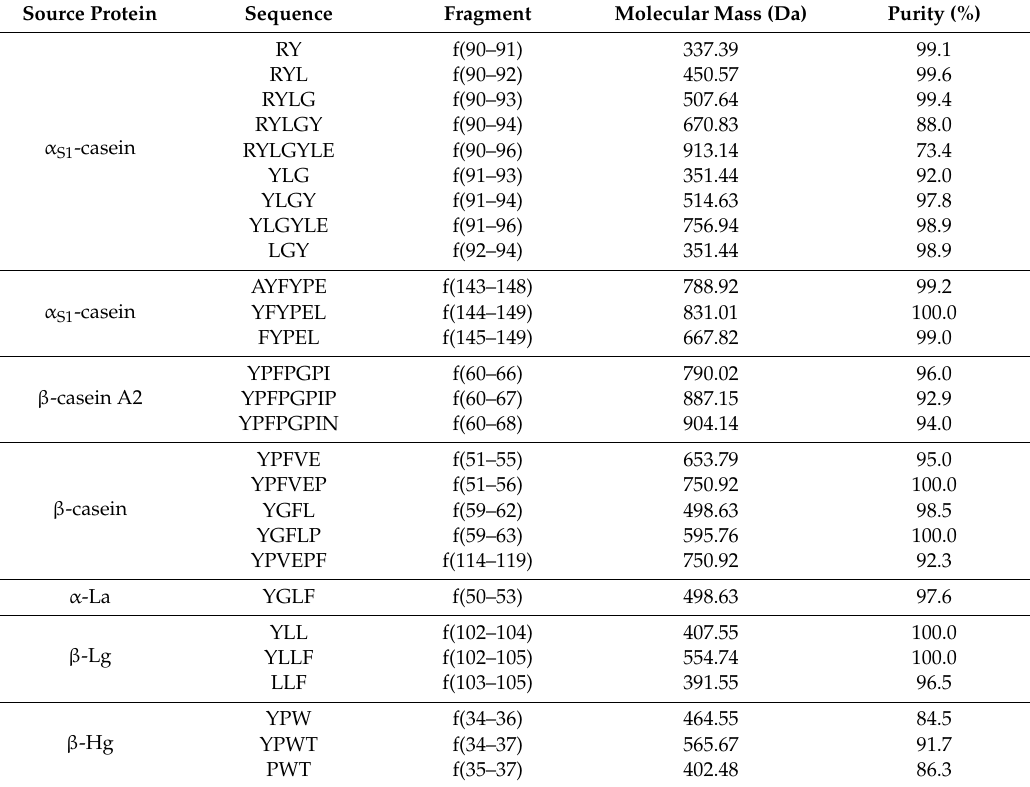
Table 1. Source protein, fragment, sequence, molecular mass, and purity of synthetic peptides used in the present